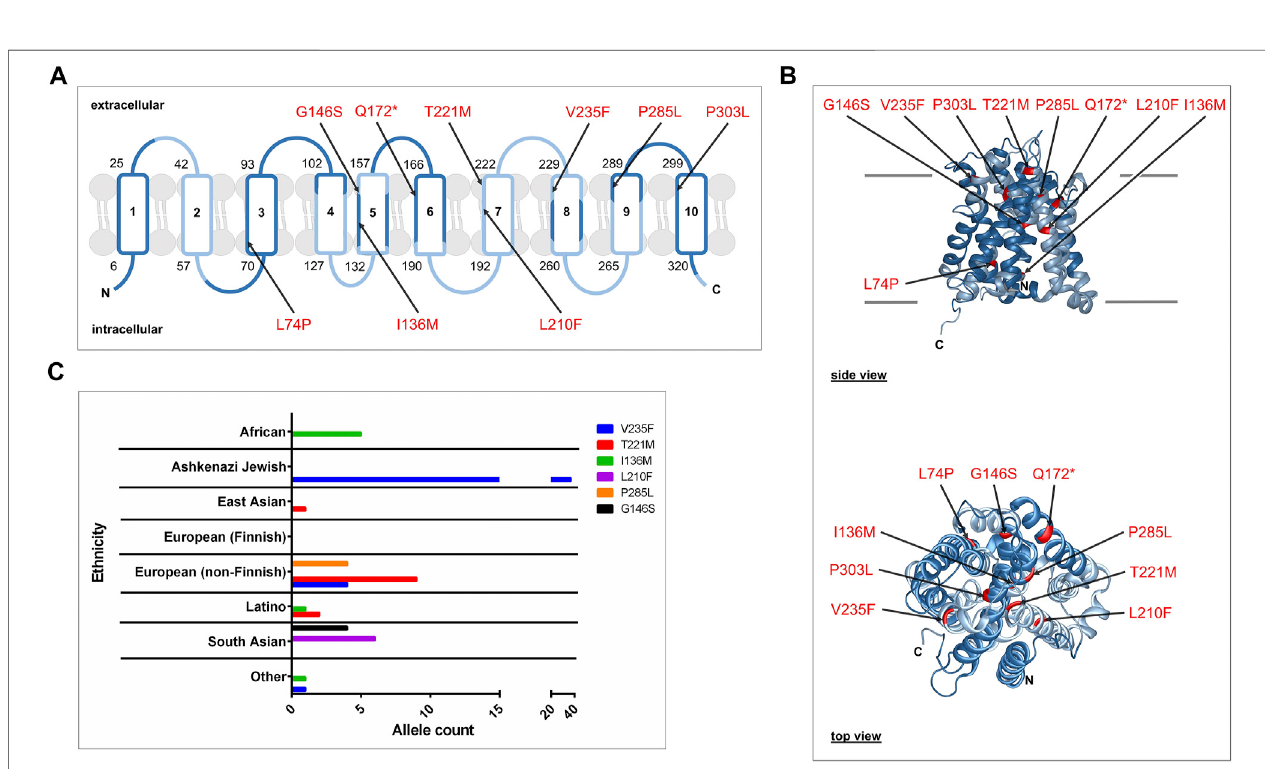
FIGURE 1 | SLC10A7 rare genetic variants predicted to be damaging or possibly damaging. (A) Schematic membrane topology model of the human SLC10A7/ RCASproteinisoformbwithits10transmembranedomains(TMDs).Thisproteiniscodedby12exons,asindicatedbyalternatingdarkblue(exons1,3,5,7,9,11)and light blue (exons 2, 4, 6, 8, 10, 12) labeling. The N- and C-terminal ends are both located inside the cell. Numbers indicate the amino acid positions at the beginning and end of each TMD. Arrows show the localization of the nine SLC10A7 variants investigated here. (B) Side and top views of a 3D homology model of the